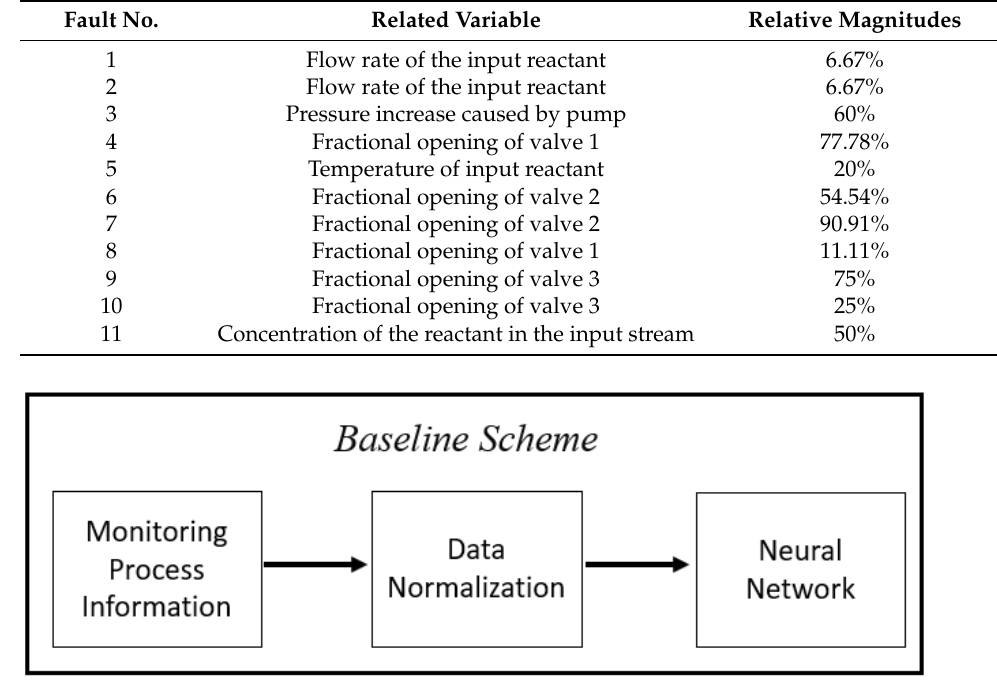
Table 3. Process parameter values for building the neural network models.